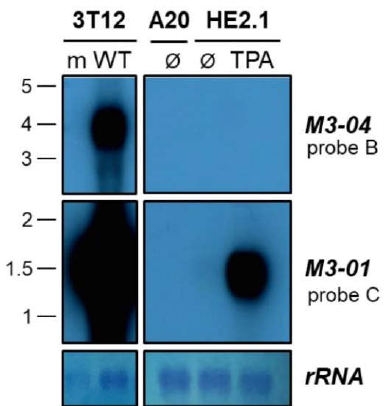
Figure 6. M3-04 is expressed during lytic replication in fibroblasts, but not in latent or reactivated B cells. Total RNA was harvested at 18 hours from mock-infected (m) or wild-type MHV68-infected (WT) NIH 3T12 fibroblasts, or from B cells lines A20 (uninfected), HE2.1 (latently infected), or HE2.1 treated with TPA for 18 hours (reactivation from latency). Northern blots were probed with strand- specific M3/M2 locus probes B or C. Methylene blue staining is shown for rRNA as a loading control.